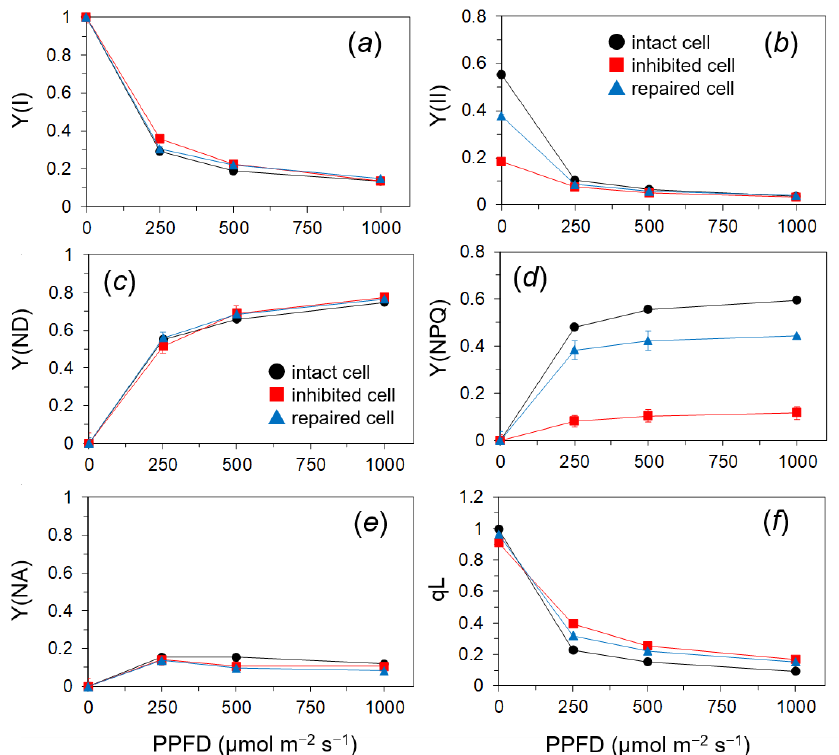
Figure 3. Responses of PSI ( a , c , e ) and PSII ( b , d , f ) parameters in the marimo filamentous cells to continuous light at various irradiances of actinic light in the different states of PSII: the intact cell (black line), the inhibited cell (photoinhibitory treatment for 60 min; red line), and the repaired cell (blue line). For the PSI parameter, Y(I) ( a ), Y(ND) ( c ), and Y(NA) ( e ) are shown. For the fluorescence parameters, Y(II) ( b ), Y(NPQ) ( d ), and qL ( f ) are shown. These parameters were obtained in the